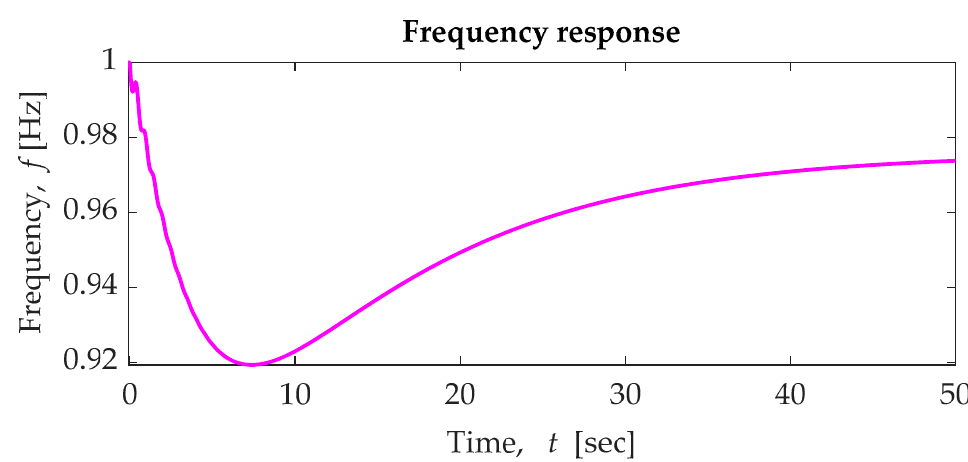
Figure 9. Under frequency event applied to the synchronous generators to assess the inertial response. Five different synchronous generators are considered in the assessment, two of them low speed used at steam turbines (ST) and the remaining are typically found at gas tur- bines (GT); full details are shown in the embedded table in Figure 10. The rotational inertia of those generators ranges from 4.4 s to 9.2 s, considering generation unit sizes from 28 MVA up to 255 MVA. Time-domain simulations are used to obtain the inertial response of each generator to the under frequency event, and time-series of the active power (also called inertial power) are presented in Figure 10. It is clear that the larger the rotational inertia ( H ), the higher the initial active power immediately after the disturbance (maxi- mum 50.37 MW of 210 MVA, 9.2 s generation unit). Additionally, large rotational inertia implies more energy released during the frequency event.